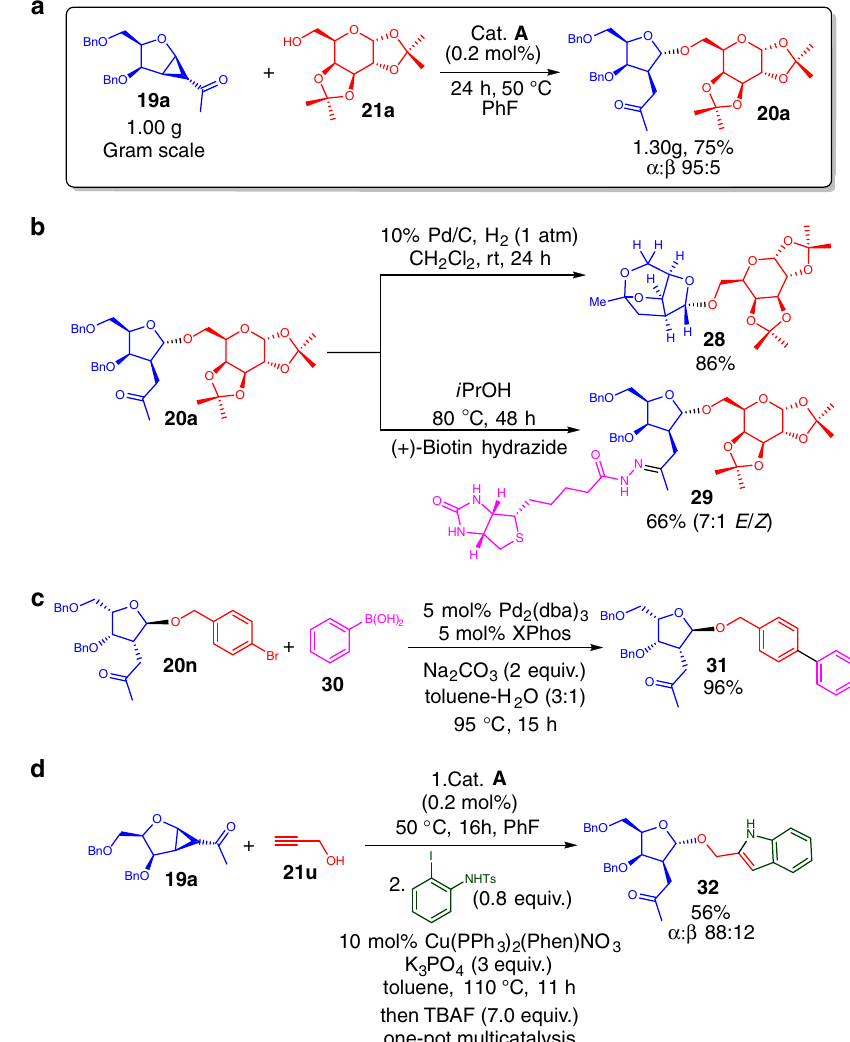
Fig. 3 Further derivatizations. a Gram scale reaction. b Hemiketalization/ketalization cascade and biotinylated hydrazone formation. c Suzuki coupling to access 31 . d One-pot multicatalytic strain-release glycosylation/[3 + 2]-cycloaddition